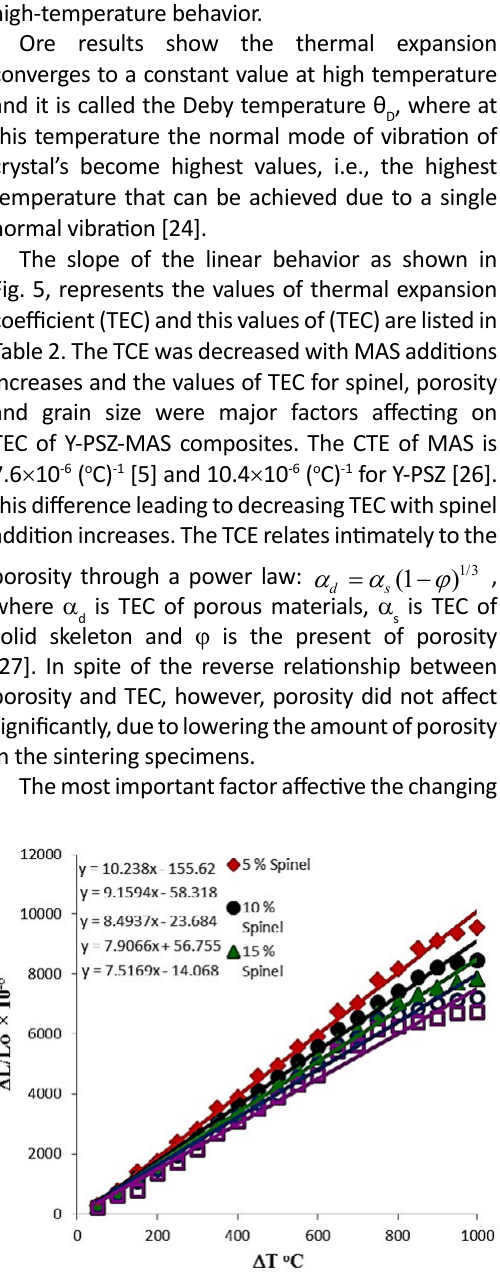
Fig. 4. The grain size dependence of the thermal diffusivity for Y-PSZ with different MAS additions.